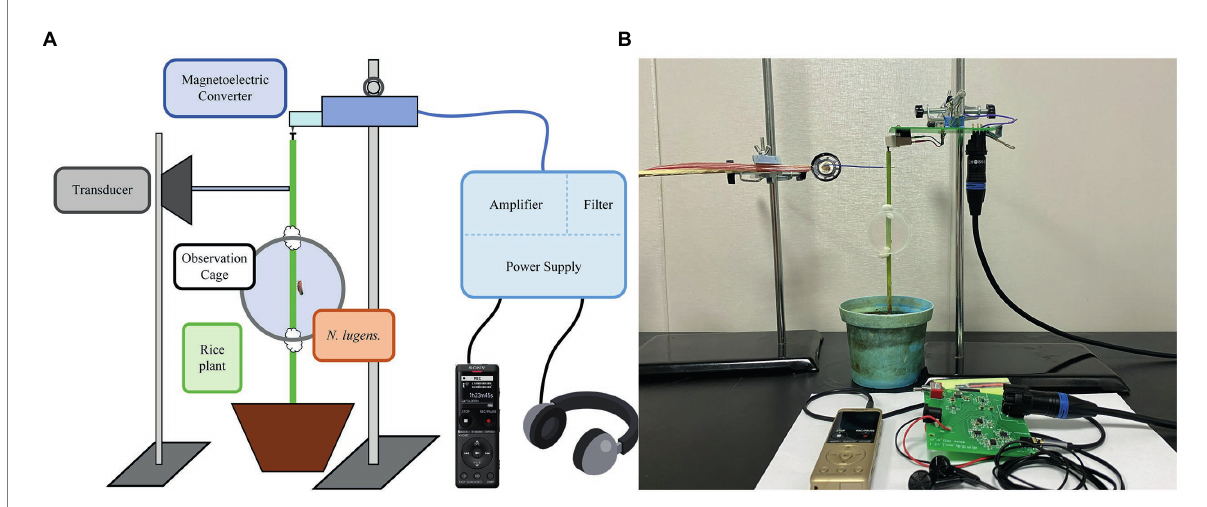
FIGURE 2 Vibration signal recording, monitoring, and playback system of BPH: (A) System framework diagram; (B) Physical image of the